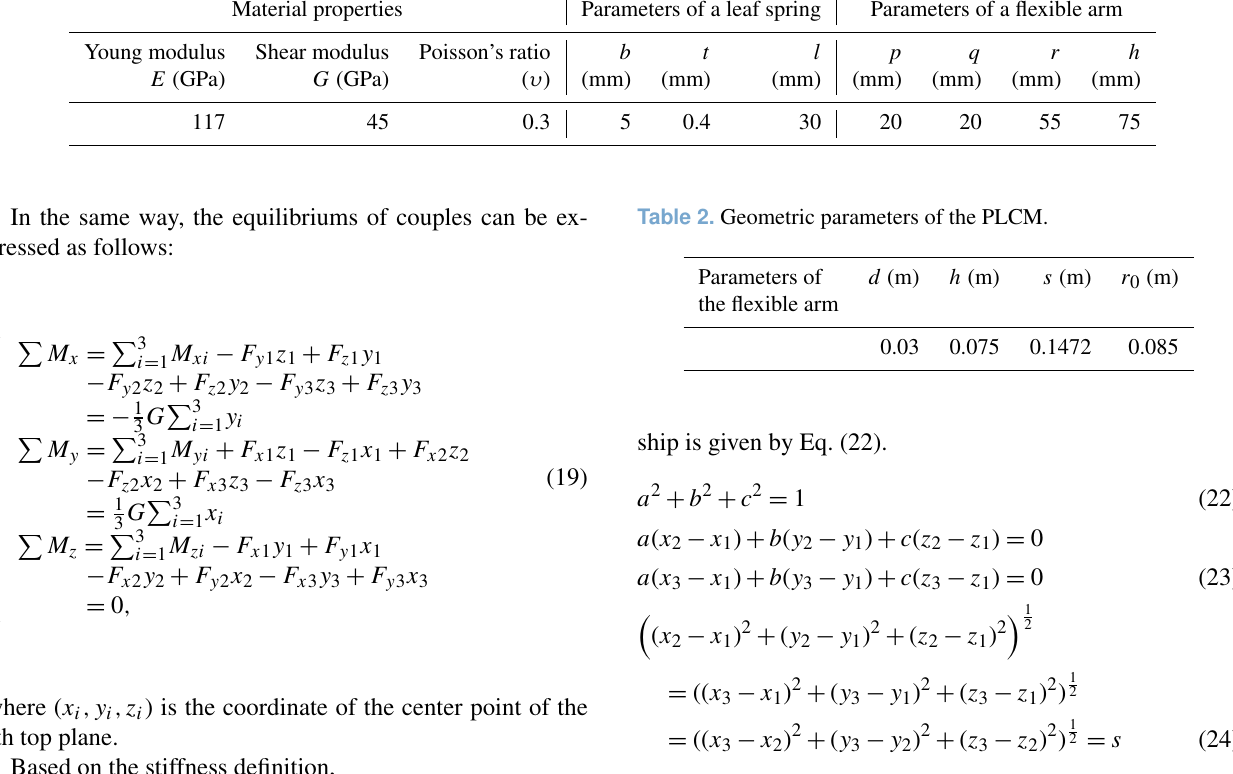
Table 1. Physical parameters of the PLCM in its initial state. Material properties